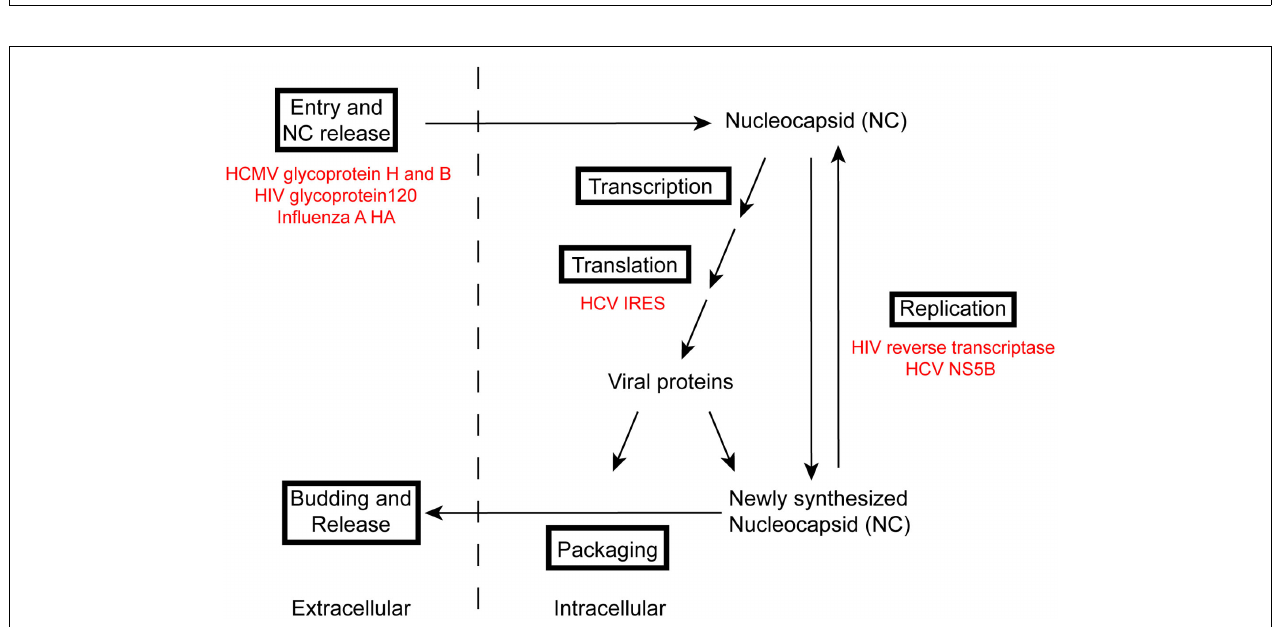
FIGURE 1 |The SELEX process. An initial pool of dsDNA is in vitro transcribed.The resulting pool of RNA is subjected to (A) counter selection and/or (B) selection by filter binding. (C) Selected RNA is recovered,